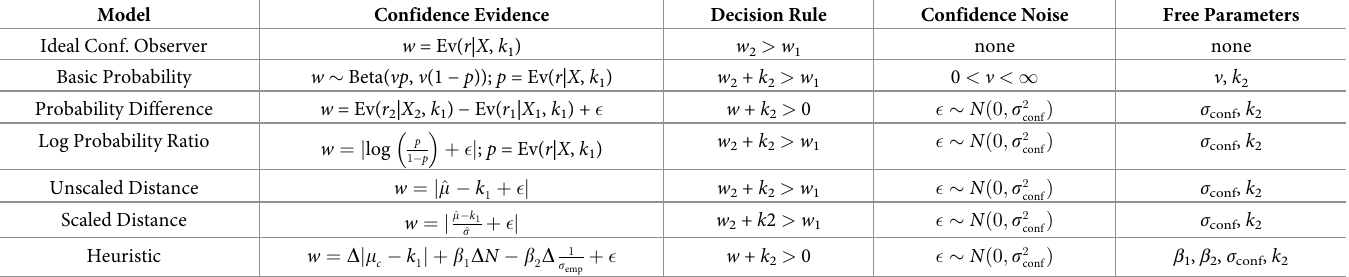
Table 3. Equations for the seven base Type 2 Confidence models. The models consider the decision evidence, Ev(), in favour of the perceptual choice, r , given the dot measurements, X , and Type 1 decision criterion, k 1 . The DFC Evidence-Strength models take a point estimate of the posterior’s mode ( ^ m ), with or without scaling by the posterior’s spread ( ^ s ), and compare its unsigned distance from k 1 . Confidence forced-choice judgements involve comparing the relative confidence evidence for the inter- vals ( w 1 versus w 2 ), with an influence of a confidence interval bias, k 2